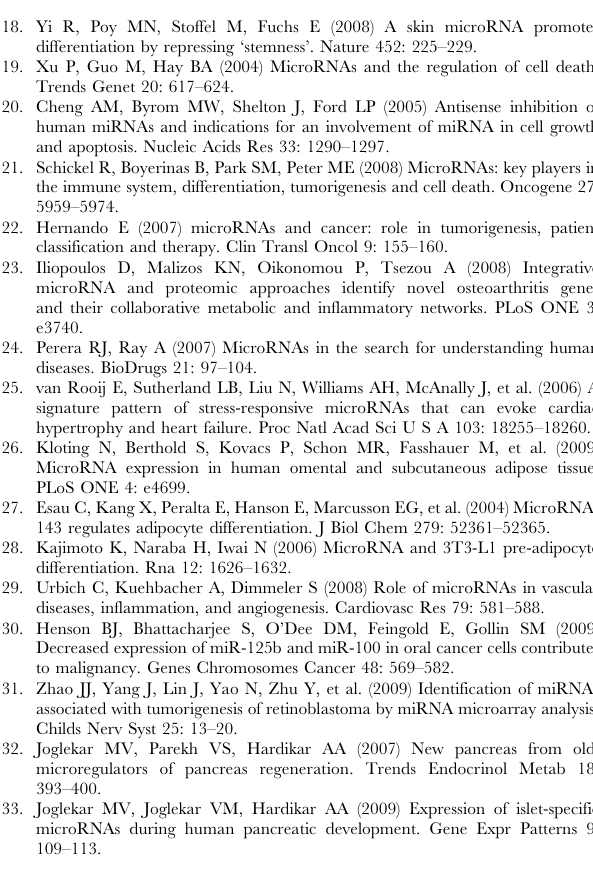
Table S2 Significant fold-changes for miRNA expression in subcutaneous adipose tissue. Table S3 Significant correlates of miRNA expression in subcutaneous fat